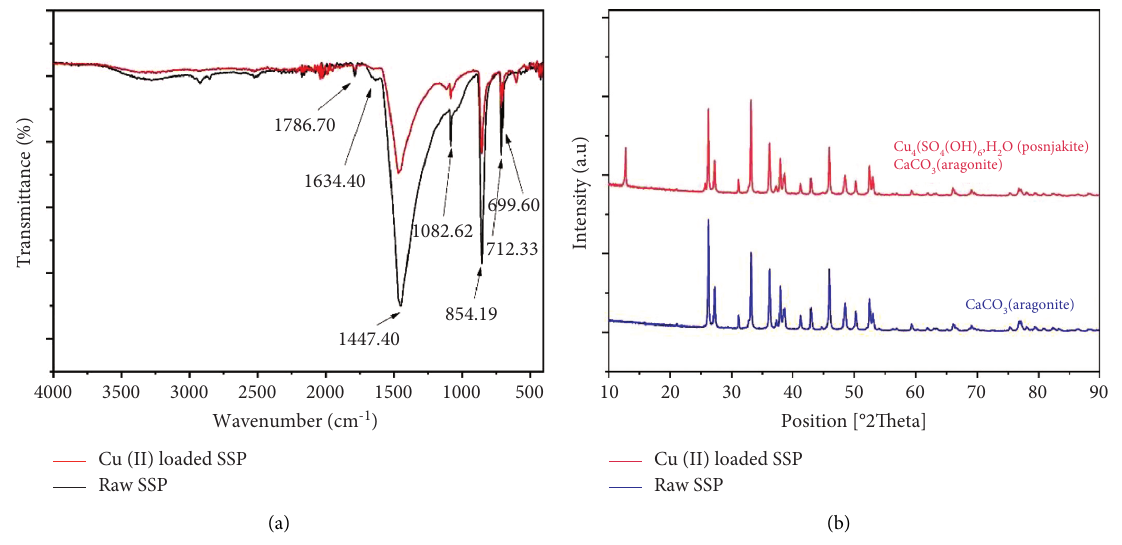
Figure 2: Characterization of raw SSP and Cu(II) loaded SSP: (a) FTIR spectrum; (b) X-ray patterns.